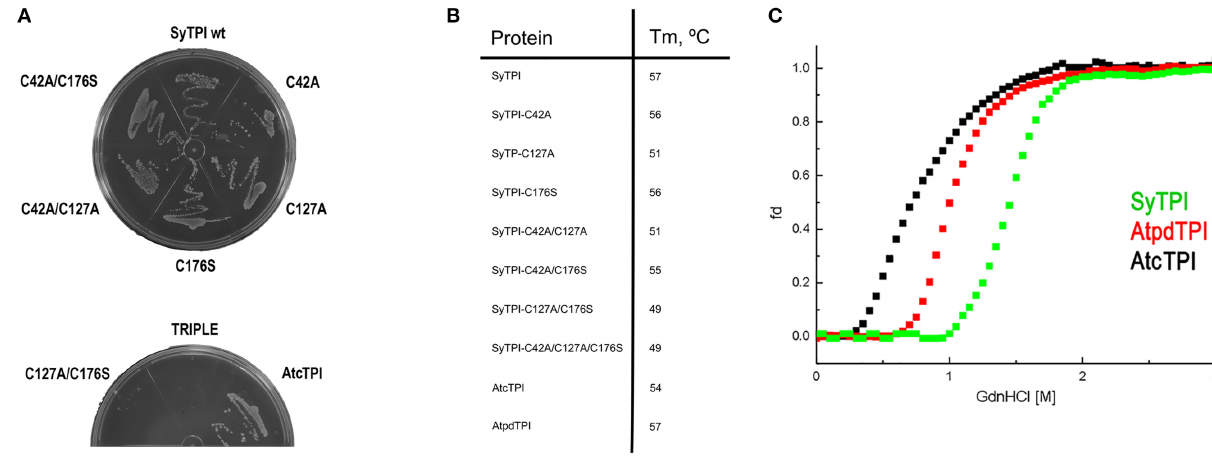
FIGURE 4 | (A) LB agar plates showing the in vivo complementation of E. coli BL21 (DE3) 1 tpi cells by plasmids expressing wild-type and mutants SyTPI and wild-type AtcTPI as positive control. (B) Thermal denaturation profiles of wild-type and point mutant SyTPIs in comparison to AtcTPI and AtpdTPI. (C) Gdn-HCl denaturation curves of SyTPI in comparison to AtcTPI and AtpdTPI. The y axes represent the percentage of unfolded protein (fd) and the x axis the Gdn-HCl concentration. Data measured the fluorescence of the samples at 280nm.